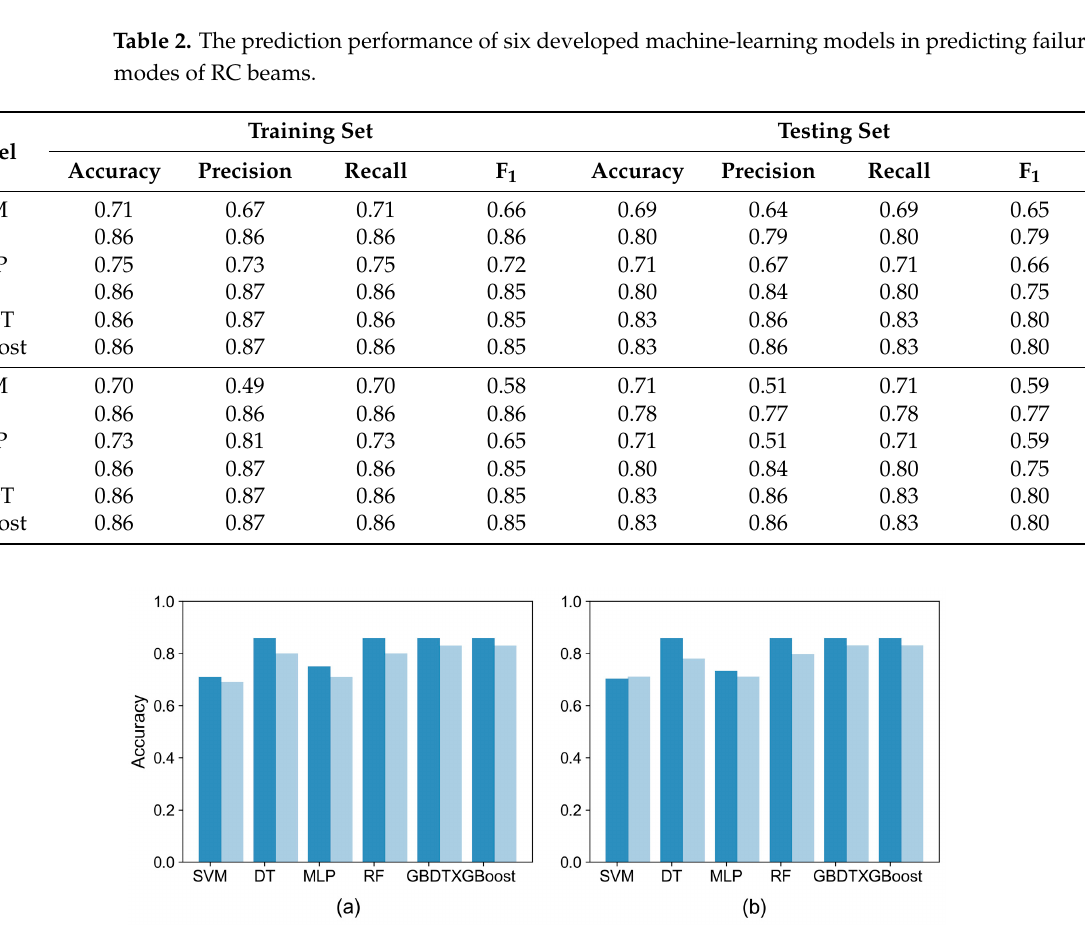
Figure 4. The performance (accuracy) for ( a ) model 1 ( λ , λ sv, f t ) and ( b ) model 2 ( λ , λ sv, f (cid:48) c (cid:3178)